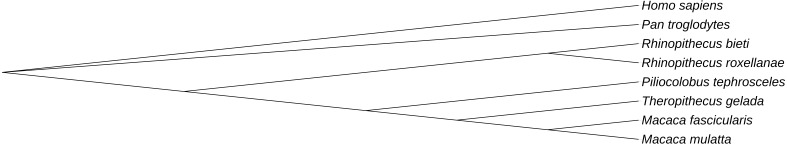
Phylogenetic relationship of similar ERVs.Phylogenetic tree was based on the similar ERV sequences found in eight species and showed the evolutionary relationship of the similar ERV sequences in different primate species.